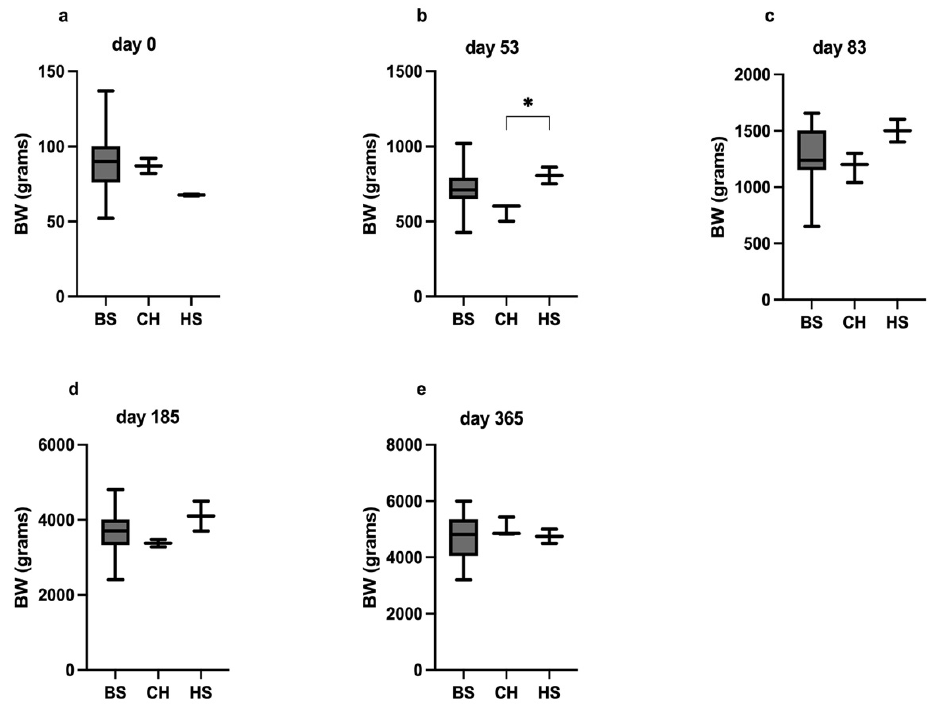
Figure 6. The differences in BW among the groups at days 0 ( a ), 53 ( b ), 83 ( c ), 185 ( d ), and 365 ( e ). The * indicates a significant difference in the multiple comparisons Dunn’s test, p < 0.05.